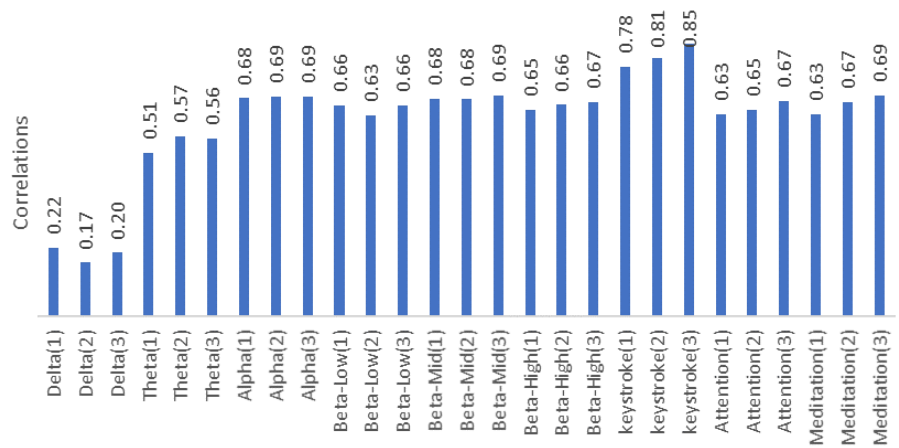
Figure 15. Game performance (T-score) correlation of EEG data and number of keystrokes per round in the GDTS track.